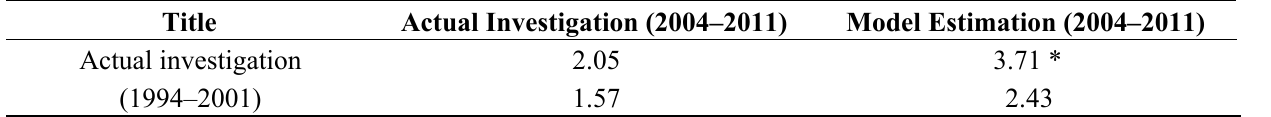
Table 2. The absolute value of tow sample t test for different periods.